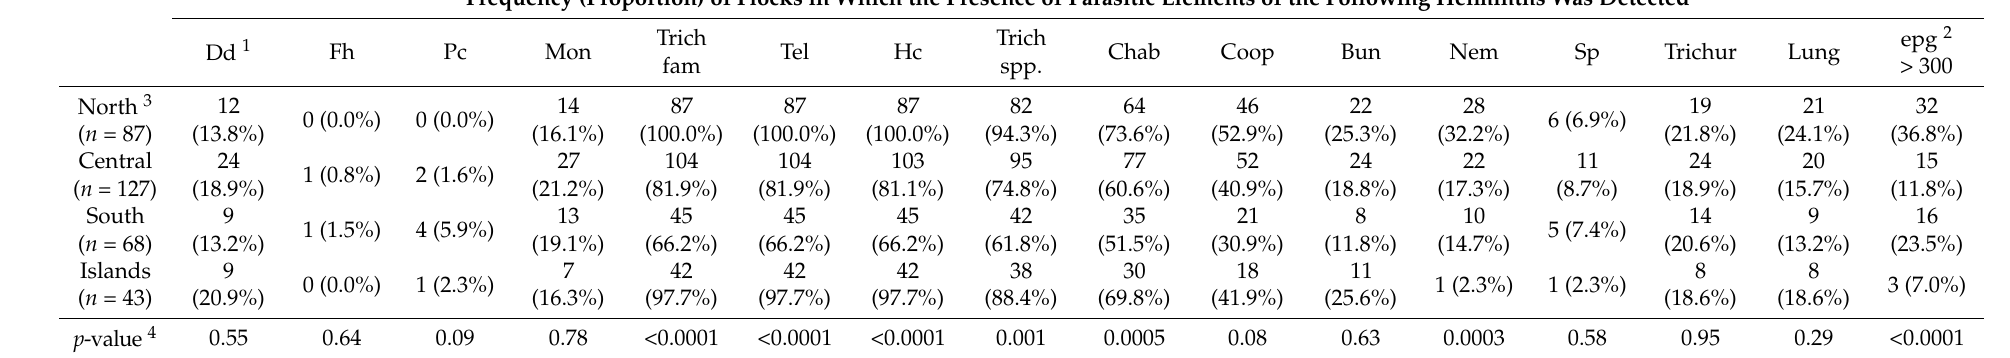
Table 3. The results of parasitological examinations in pooled faecal samples from 325 sheep flocks in a countrywide investigation in Greece, in accord with the geographical area of the